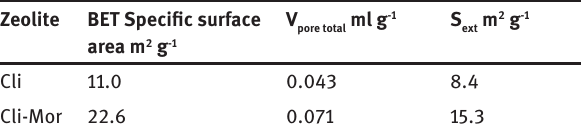
Table 3: Surface properties of original zeolite samples Zeolite BET Specific